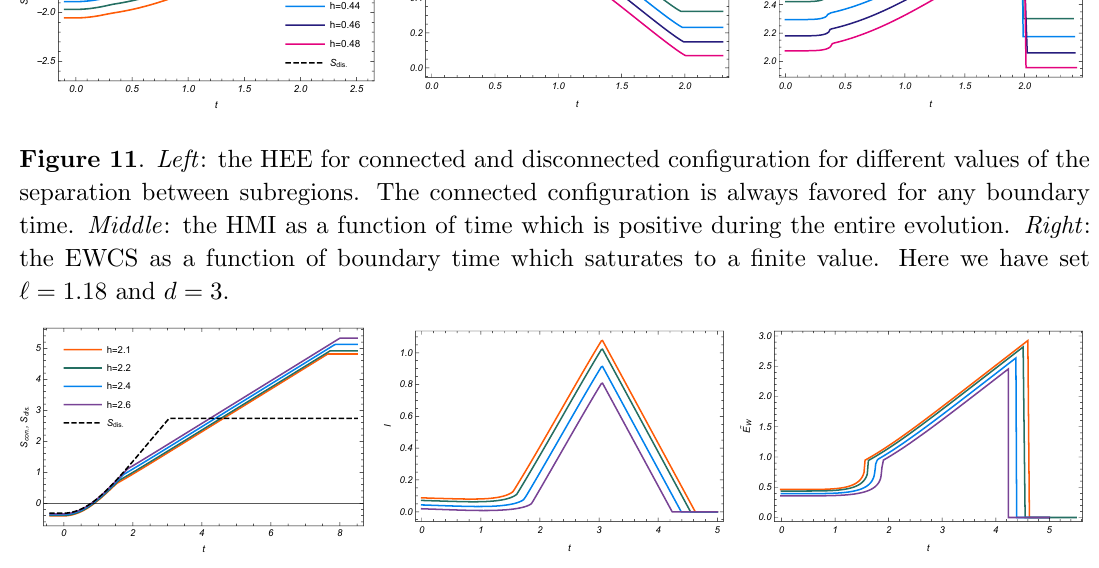
Figure 12 . Left : the HEE for connected and disconnected con(cid:12)guration for di(cid:11)erent values of h . At late times, the disconnected con(cid:12)guration is favored. Middle : the HMI as a function of time which vanishes at late times. Right : the EWCS as a function of boundary time which saturates to zero. Here we have set ‘ = 4 : 5 and d =